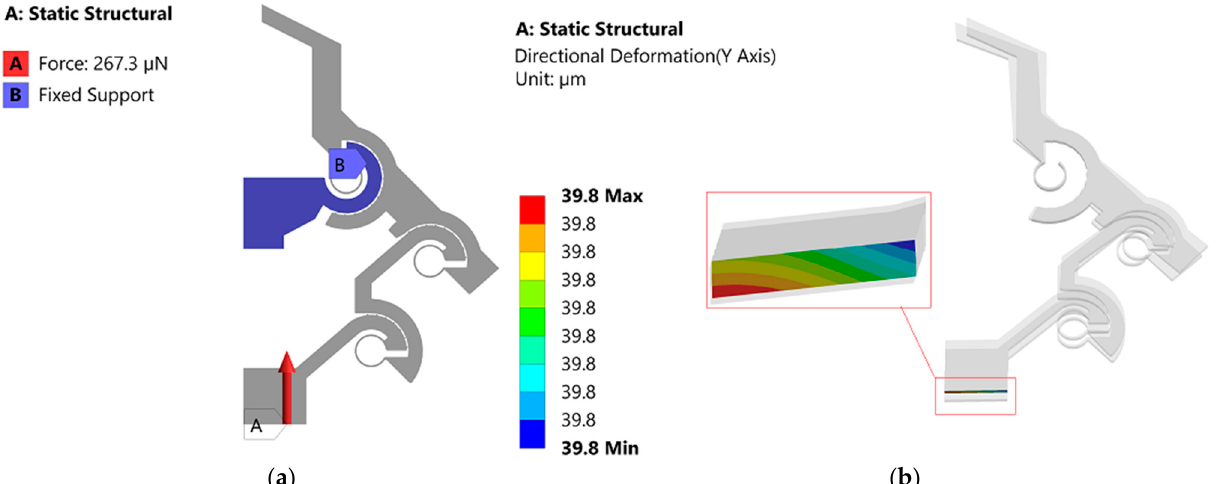
Figure 9. ( a ) Boundary conditions of the static structural analysis; ( b ) directional displacement along the vertical direction at the shuttle of the microgripper when a full range input displacement is applied.